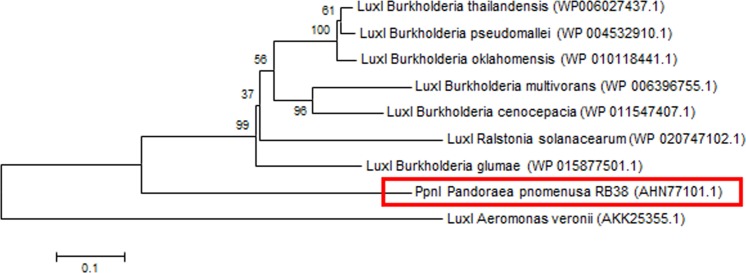
Phylogenetic tree of PpnI.Neighbor-Joining method (Saitou & Nei, 1987) was used in MEGA6 (Tamura et al., 2011) where bootstrap test (1,000 replicates) is shown next to the branches (Felsenstein, 1985).